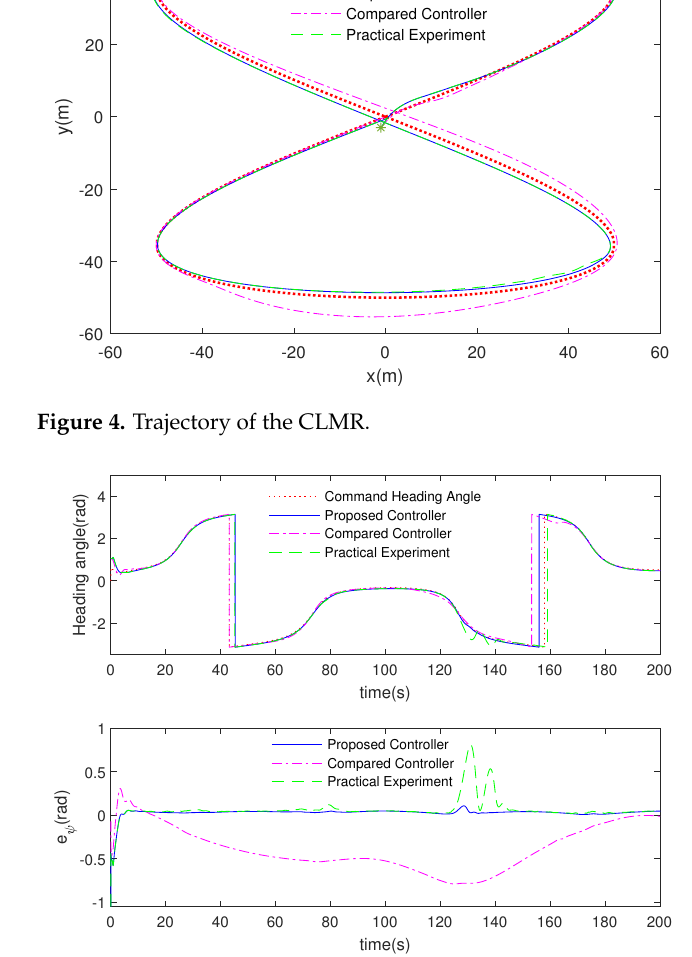
Figure 5. Heading